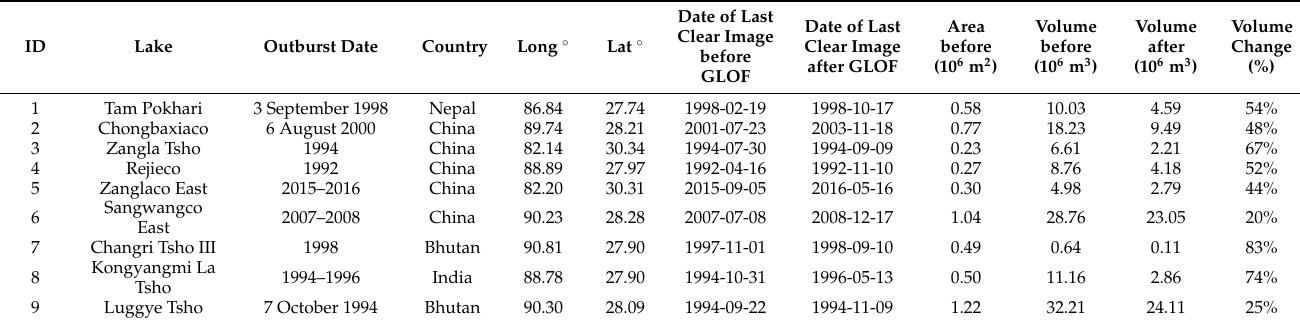
Table 3. Moraine-dammed lake (>0.2 km 2 ) outburst events in the Himalayas since the late 1980s. Data from Veh et al. (2019).